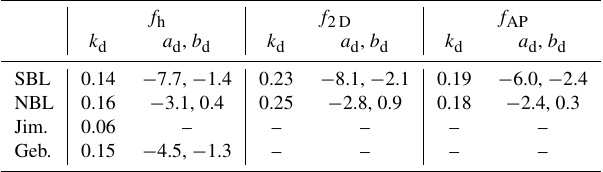
Figure 15. RMSE of the time series of 3min averaged a h and u h at two different positions in the model domain separated by (cid:49)x = 8D, with a advection time shift of the downstream time series of τ (Eq. 7) and without time shift ( τ = 0).